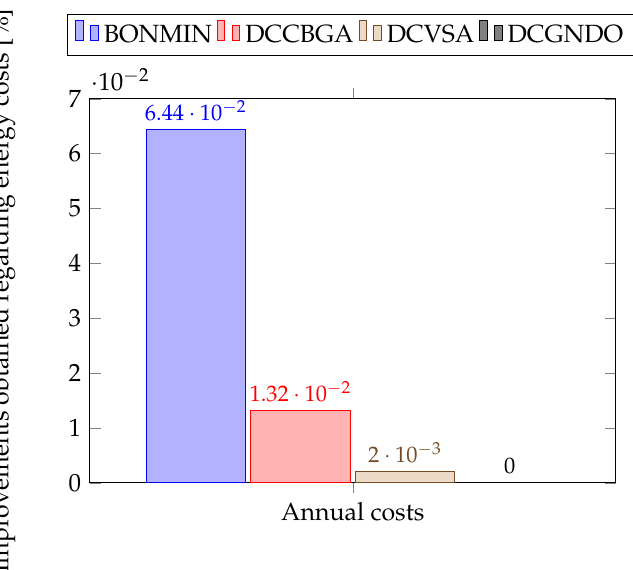
Figure 4. Improvements regarding annual cost reduction achieved by the DCPPSO with respect to the comparison methods in the 33-bus test